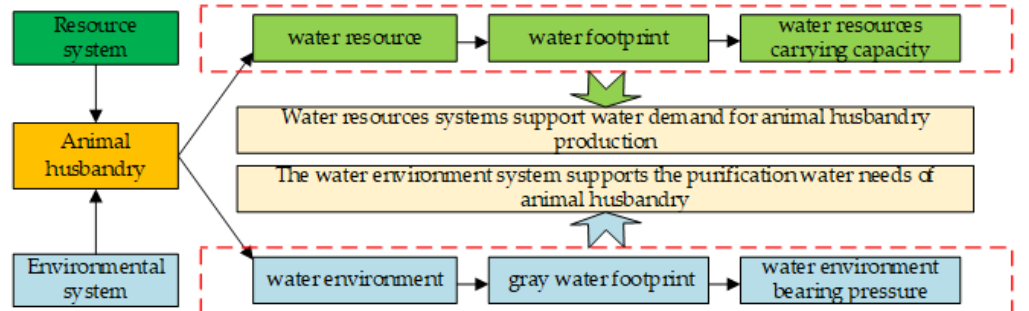
Figure 1. Research framework for animal husbandry water resources and water environmental carrying capacity based on Water Footprint Theory .